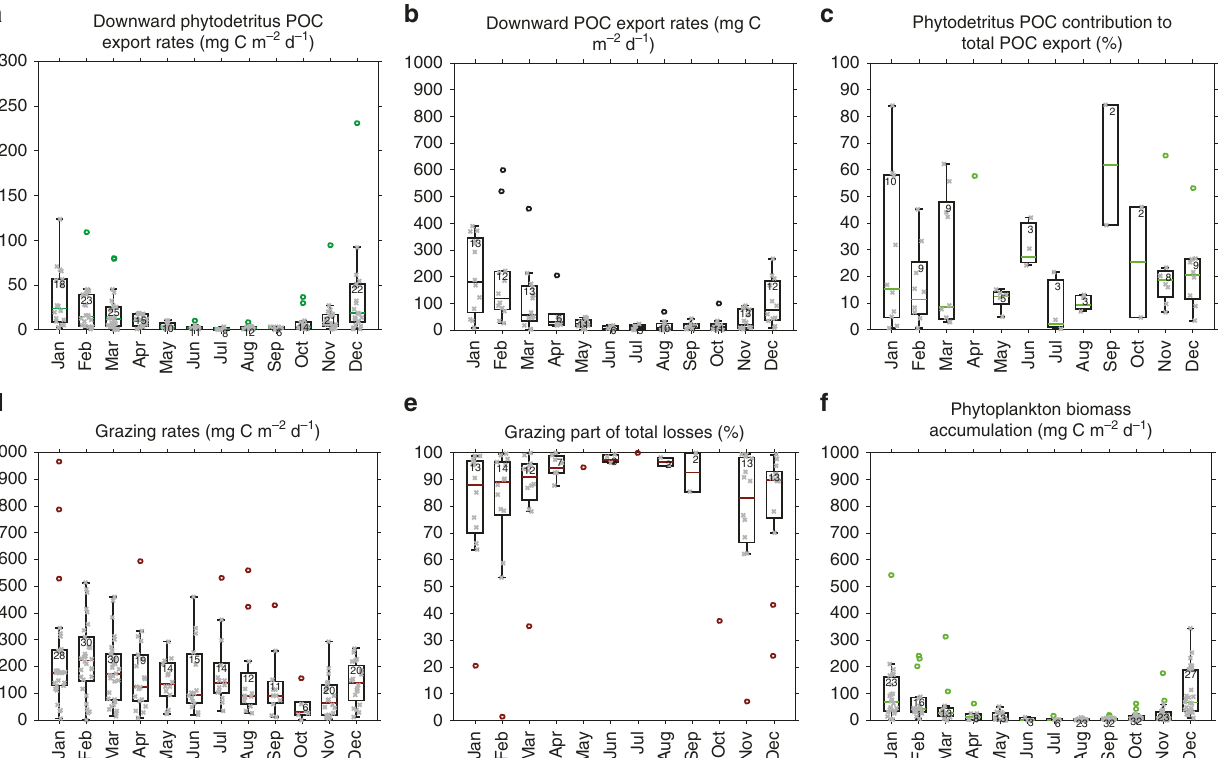
Fig. 4 Seasonal evolution of phytoplankton fates. Box plot of integrated a phytodetritus POC export (mg C m − 2 d − 1 ), b POC export (mg C m − 2 d − 1 ), c phytodetritus POC contribution to total POC export (%), d grazing (mg C m − 2 d − 1 ), e grazing part of total losses (%) and f phytoplankton biomass accumulation (mg C m − 2 d − 1 ). The box plot shows the median, the 50% central region, and the functional limits ([Q1 − 1.5 × IQR, Q3 + 1.5 × IQR], where Q1 and Q3 are the 25th and 75th percentiles respectively, and IQR is the interquartile range). Data are plotted as crosses and outliers as circles. The sample size is indicated for each